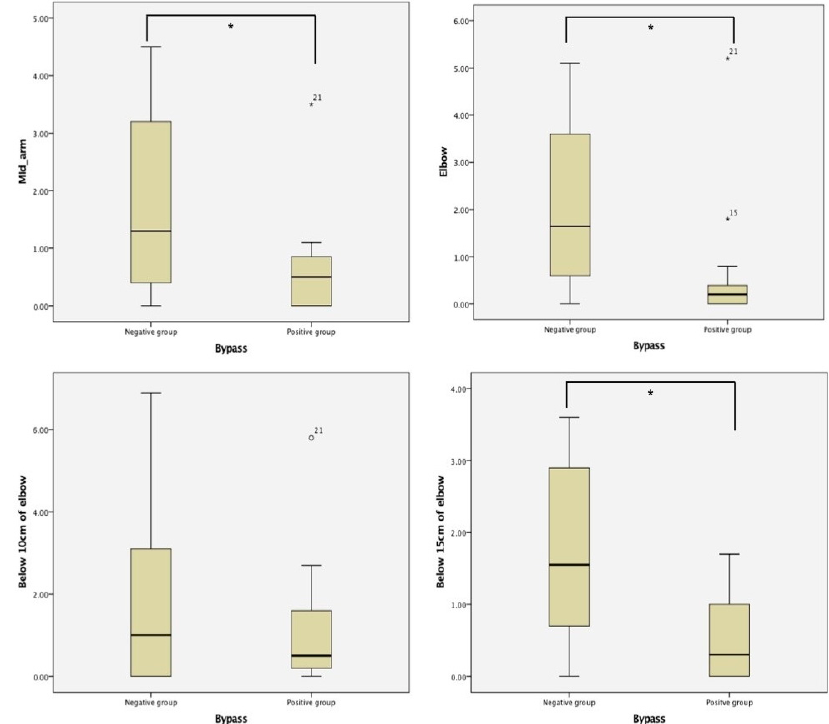
Figure 1. The difference in circumference on the upper extremities at four points according to bypass circulation positive and negative groups. The four points of the upper extremity are the mid-point of the upper arm, elbow, 10 cm below the elbow, and 15 cm below the elbow, respectively. The negative group shows significant severe lymphedema compared to the positive group at the mid-arm, elbow, and 15 cm below the elbow. * p < 0.05. Table 2. Occurrence of bypass lymphatic nodes on the affected and unaffected side.